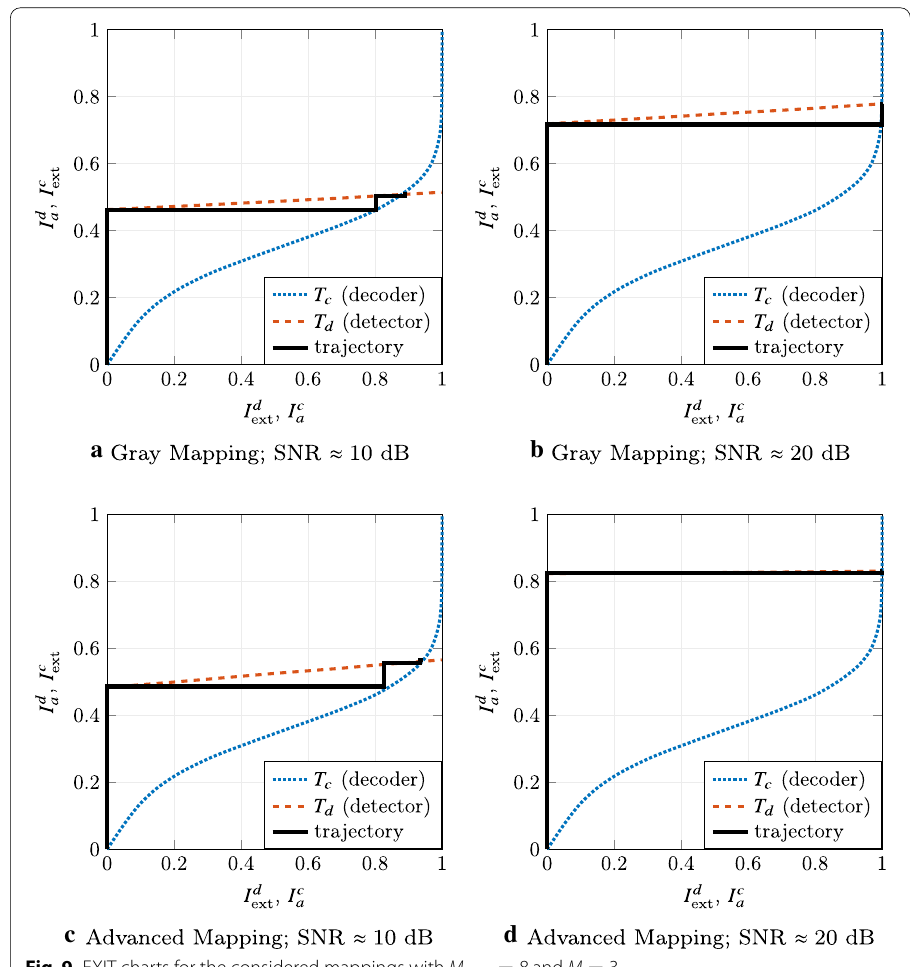
Fig. 9 EXIT charts for the considered mappings with M cpm = 8 and M =